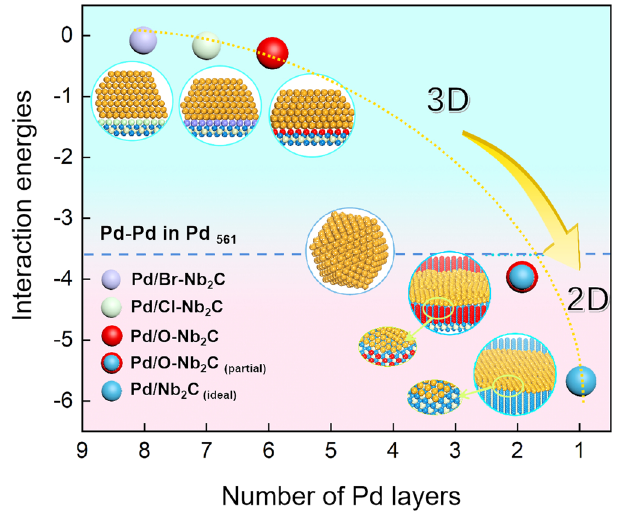
Fig. 1 | The relationship of the interaction energies between Pd and supports and the number of Pd layers in the MD simulations of Pd/MXenes catalysts. Snapshots of Pd 561 nanoparticle supported on substrates of Cl-Nb 2 C, Br-Nb 2 C, O-Nb 2 C, O-Nb 2 C (partial) and Nb 2 C (ideal) at 300K. The palladium, chlorine, bromine, oxygen,carbon,andniobiumatomsarerepresentedasblue,green,brownred,red, gray, and dark green spheres,